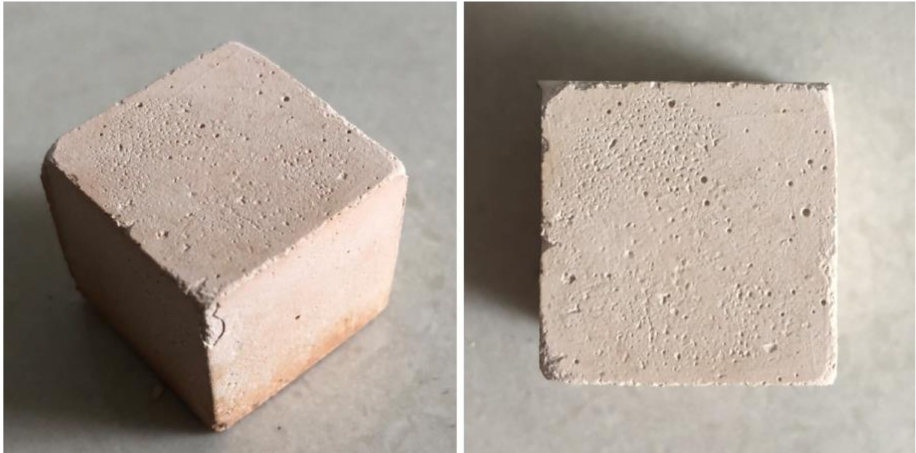
Figure 8. Pictures of sample